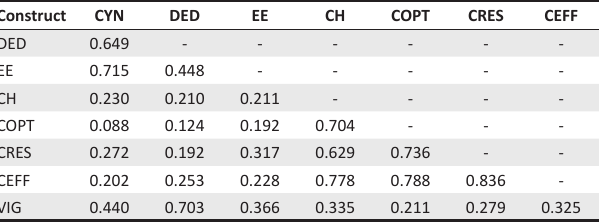
TABLE 3: Heterotrait-monotrait ratio of correlations (all first-order